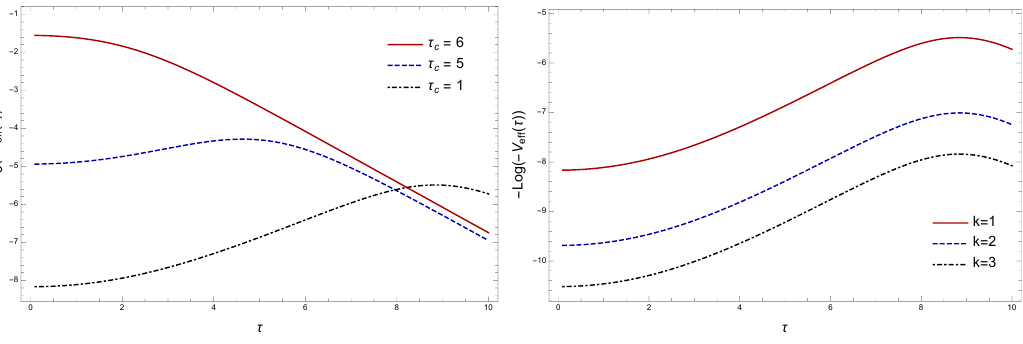
Figure 3 . Effective potential V eff corresponding to the first mode for different choices of τ c (left) and for the first 3 modes when τ c = 9 (right), both with T = 10